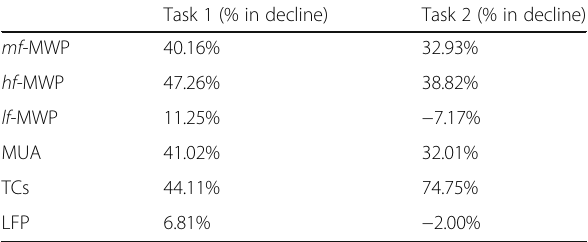
Negative value in decline means the signal strength